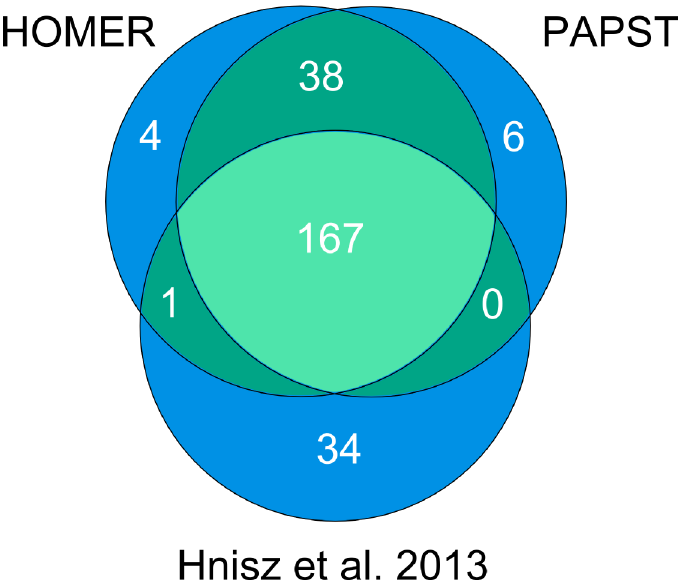
Fig 5. PAPST Gene Assignment of Super Enhancers Compared to HOMER and the Literature. PAPST was compared to two others gene assignments for super enhancer regions. PAPST and HOMER are 98% consistent with each other. The discrepancy with the Hnisz et al. [16] assignment is most likely due to the different versions of RefGene used (mostly new non-coding gene